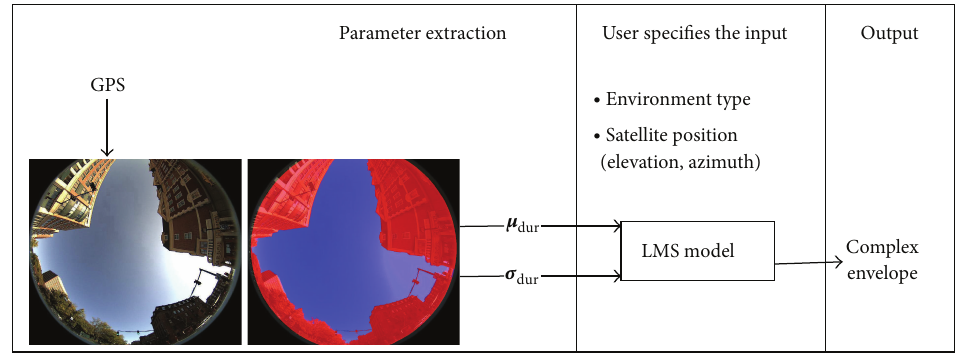
Figure 8: High-level overview of the proposed image-based LMS model. The image-based state duration parameters 𝜇 preprocessed for all possible environments and satellite positions. Depending on the user’s input, that is, environment type and satellite and 𝜎 are chosen. position, the specific 𝜇 dur dur